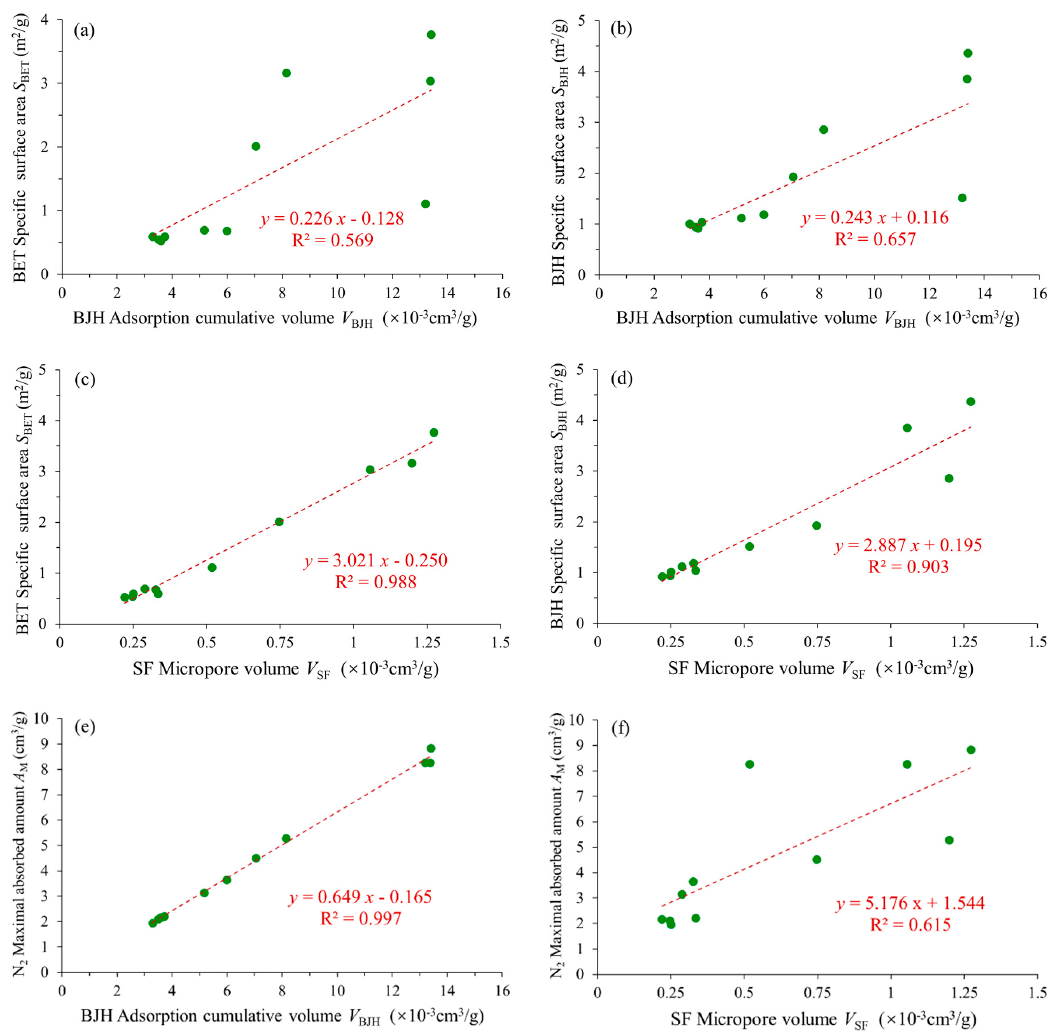
Figure 6. Univariate linear regression analysis of pore structure parameters: ( a ) Relationship between V BJH and S BET ; ( b ) relationship between V BJH and S BJH ; ( c ) relationship between V SF and S BET ; ( d ) relationship between V SF and S BJH ; ( e ) relationship between V BJH and A M ; ( f ) relationship between V SF , and A M .